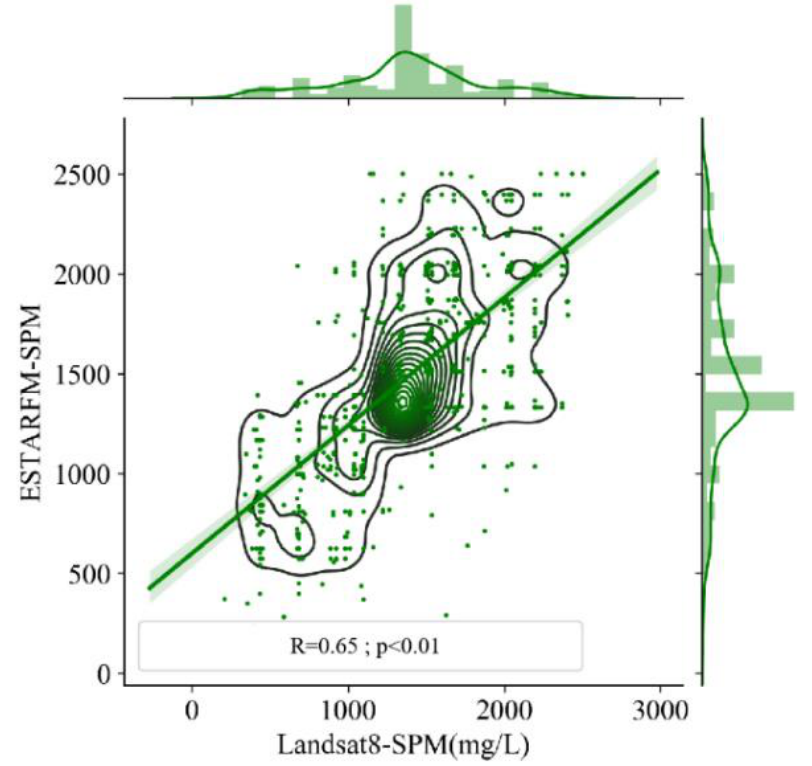
Figure 9. The correlation between Landsat 8 and ESTARFM inversions of SPM concentrations.